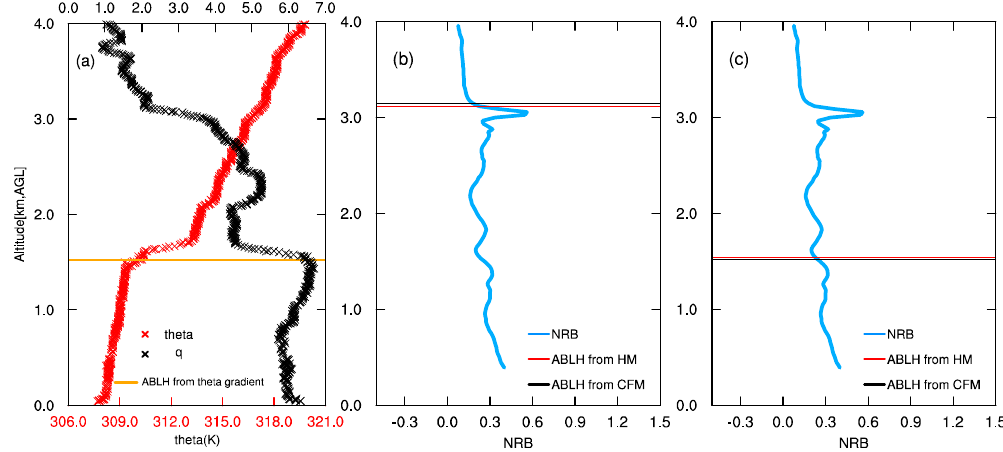
Figure 6. Similar to Figure 5, but for a cloudy case (12:00 UTC on 3 September 2010). Vertical profiles of ( a ) potential temperature (theta) and specific humidity (q) at Yuzhong site, ( b ) or ( c ) lidar NRB at SACOL, the ABLH retrieved by the Haar wavelet method (HM) and curve fitting method (CFM) ( b ) directly, ( c ) below the determined top limiter.